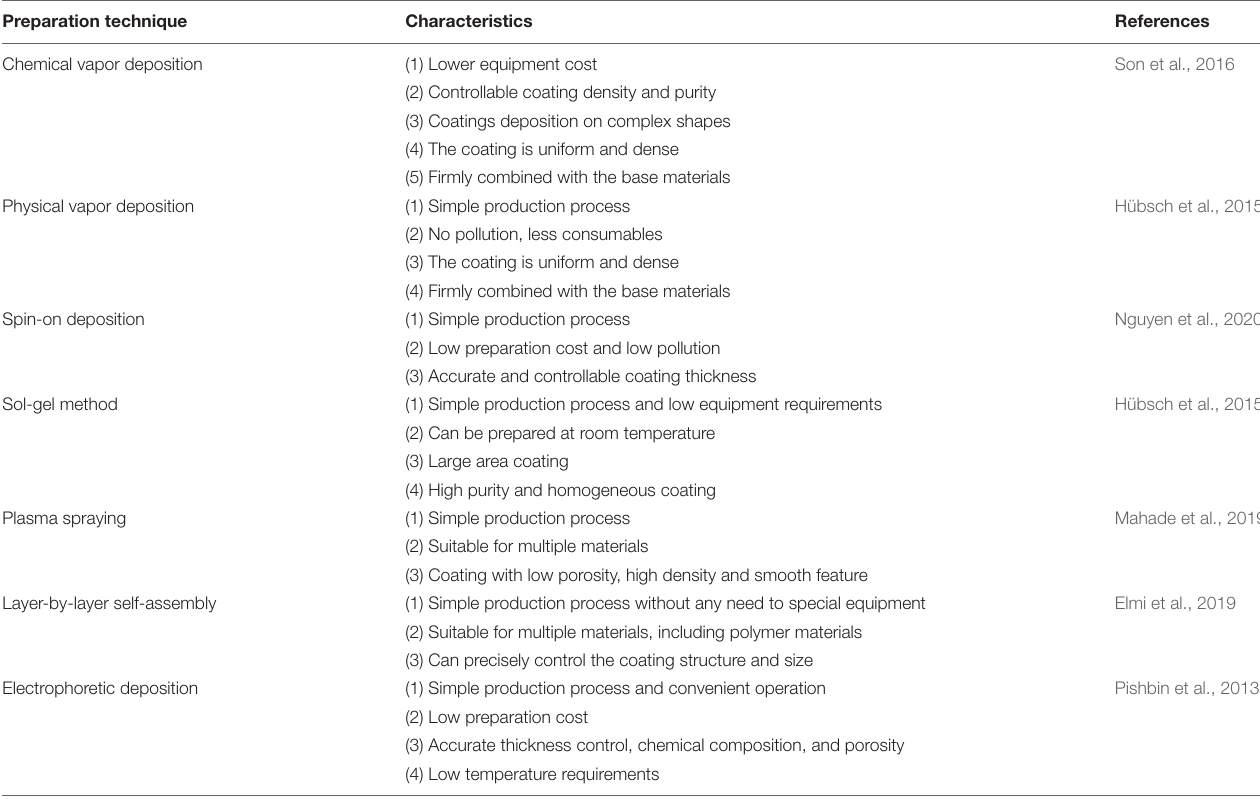
TABLE 2 | Various nano-coating preparation methods and the related